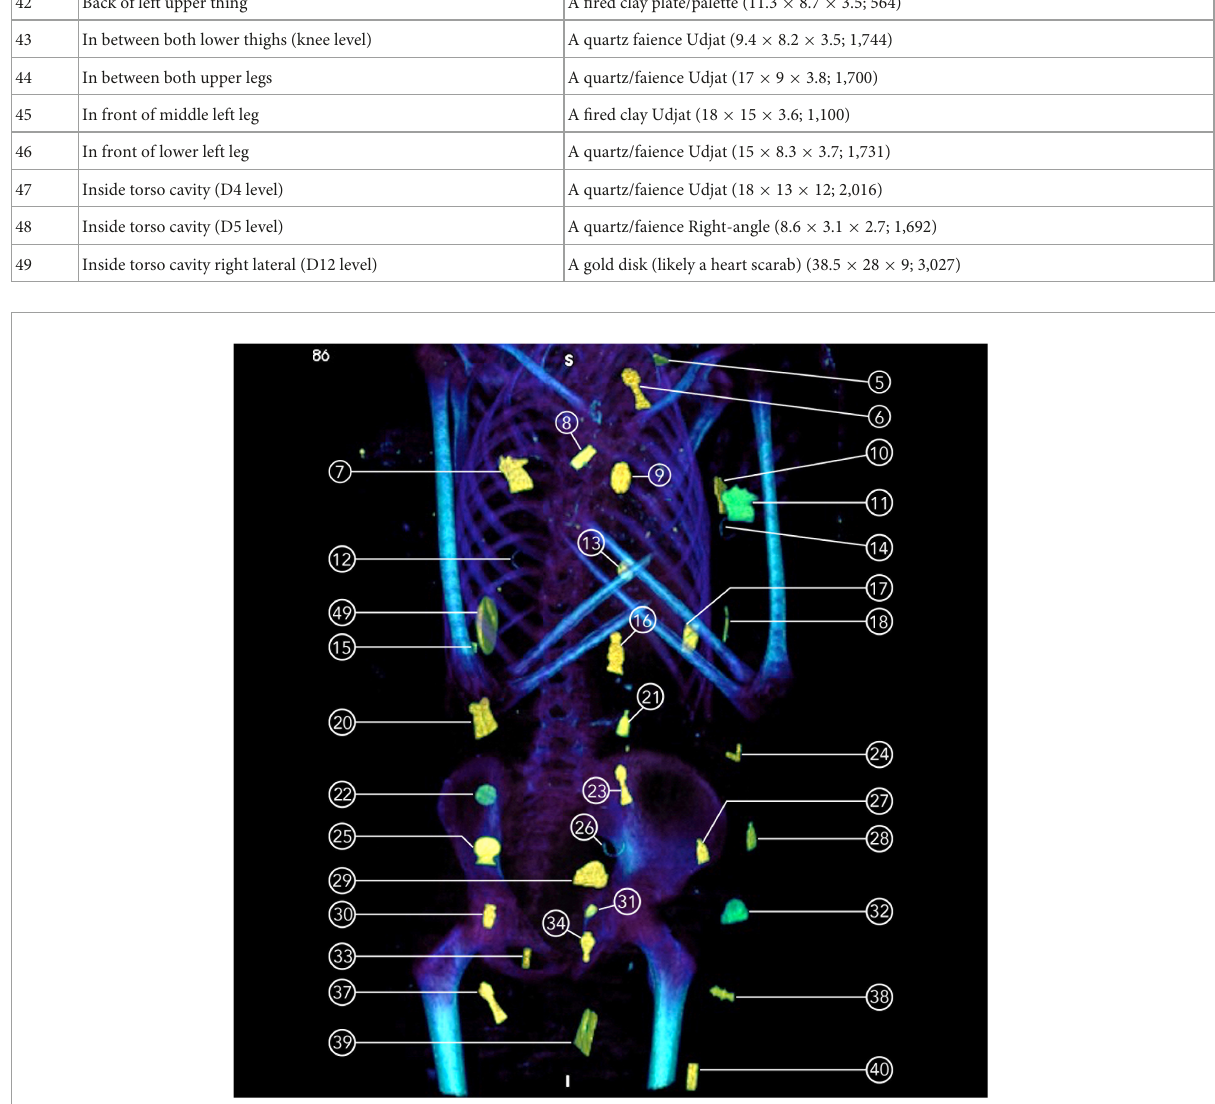
FIGURE11 Thick slab coronal computed tomography (CT) image of the torso of mummy TR 21/11/16 at the Cairo Egyptian Museum showing amulets placed on the mummy’s surface and between the wrappings (5: gold flask; 6: gold Djed; 7: gold Udjat, 8: gold Double-falcon-plume; 9: gold scarab; 10: gold Udjat; 11: stone Udjat; 12: quartz crescent; 13: gold scarab; 14: quartz crescent; 15: stone serpent head; 16: gold Tyt; 17: gold plate; 18: quartz udjat; 20: gold double ostrich plume; 21: gold flask; 22: stone placenta; 23: gold djed; 24: gold Right angle; 25 gold Nou flask; 26: quartz crescent, 27: gold flask, 28: gold flask, 29: gold ajet; 30: gold cylinder; 31: gold bead; 32: quartz Ajet; 33: gold cylinder; 34; gold flask; 37: gold Djed; 38: gold zigzag; 39: Two-finger; 40: gold